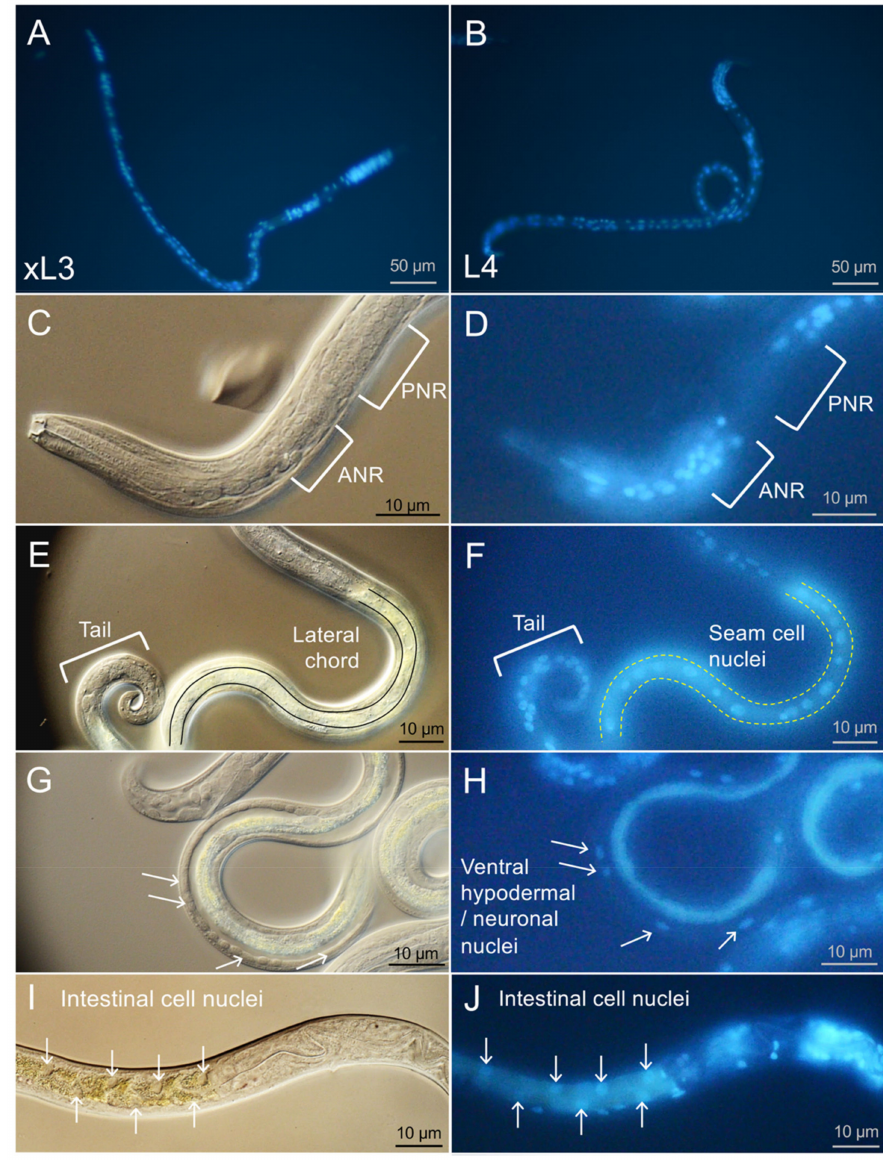
Figure 4. Bisbenzimide (BB) nuclear staining resolves tissues and cells in H. contortus larvae. xL3 ( A ) and L4 ( B ) larvae have similar BB staining profiles across the worm. L4 larval nuclei anterior to the nerve ring (ANR) visible by DIC ( C ) stain with BB ( D ), while most of those posterior to the nerve ring (PNR) do not stain, despite the presence of cells. Along the length of the lateral chord to the tail visible by DIC ( E ), seam cell and tail cell nuclei are visible by BB ( F ). Cells visible on the lateral side of the larva by DIC ( G ) contain several ventral hypodermal/neuronal nuclei stained with BB ( H ). Staggered intestinal cell nuclei visible by DIC ( I ) are visible by BB ( J ). Panel A is viewed with a 20 × objective (200 × magnification), and the remaining panels (L4 larvae) are viewed with 60 × objective (600 × magnification) and cropped/magnified digitally to highlight features. BB was incubated for 4 h pre-treatment and was included throughout the incubation period. DIC images have been adjusted for brightness and contrast individually to best highlight features of